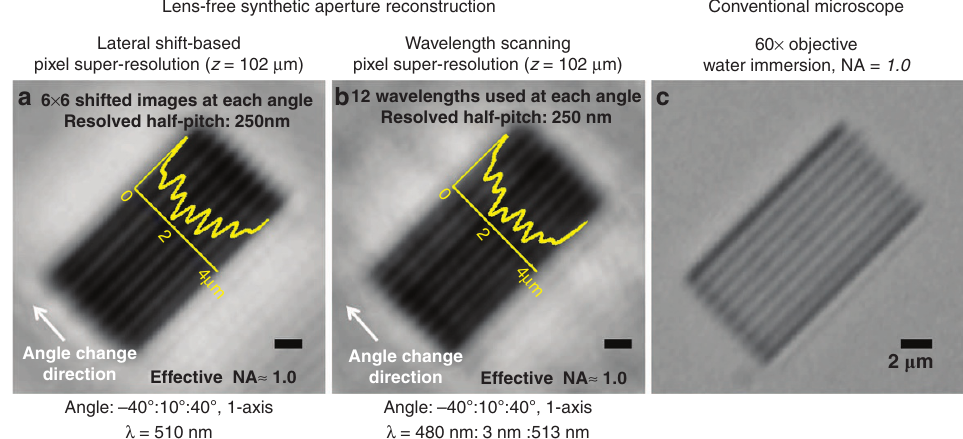
Figure 5 ( a ) Lens-free imaging using synthetic aperture and lateral shift-based pixel super-resolution. At each illumination angle, 6×6 = 36 sub-pixel lateral shifts, which are spread evenly over the pixel area, are used for super-resolution. ( b ) Lens-free imaging using synthetic aperture and wavelength-scanning pixel super-resolution. Twelve wavelengths are used within a scanning range of 480 – 513 nm and a scan step of 3 nm. The illumination angle scanning directions, ranges and scanning steps are the same in both a and b . ( c ) Image of the specimen obtained using a conventional lens-based microscope with a 60× water-immersion objective lens (NA =